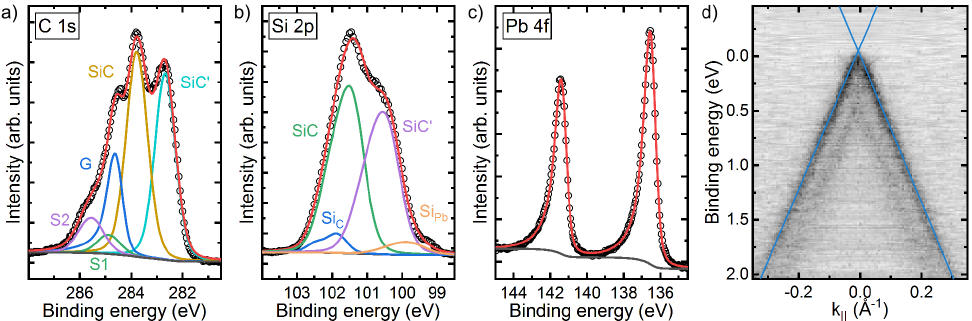
Figure 4. XPS spectra of partially Pb-intercalated BL/SiC. ( a ) C1s, ( b ) Si2p and ( c ) Pb4f state. ( d ) ARPES spectrum around the K-point of graphene. The measurements were performed at T = 300